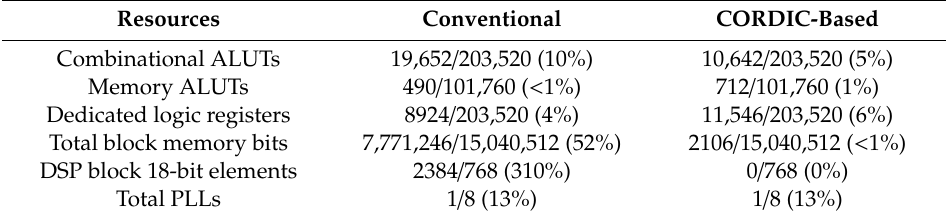
Table 2. The hardware resource consumption when conventional and CORDIC-based implementation methods are used respectively to implement the hippocampal neural network.